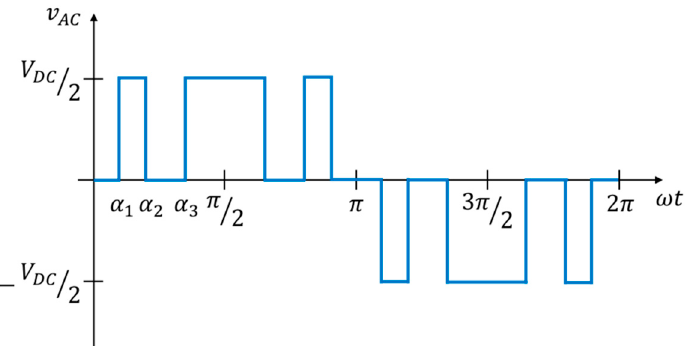
Figure 5. Three-level leg AC voltage pattern with quarter-wave symmetry with three independent switching angles.